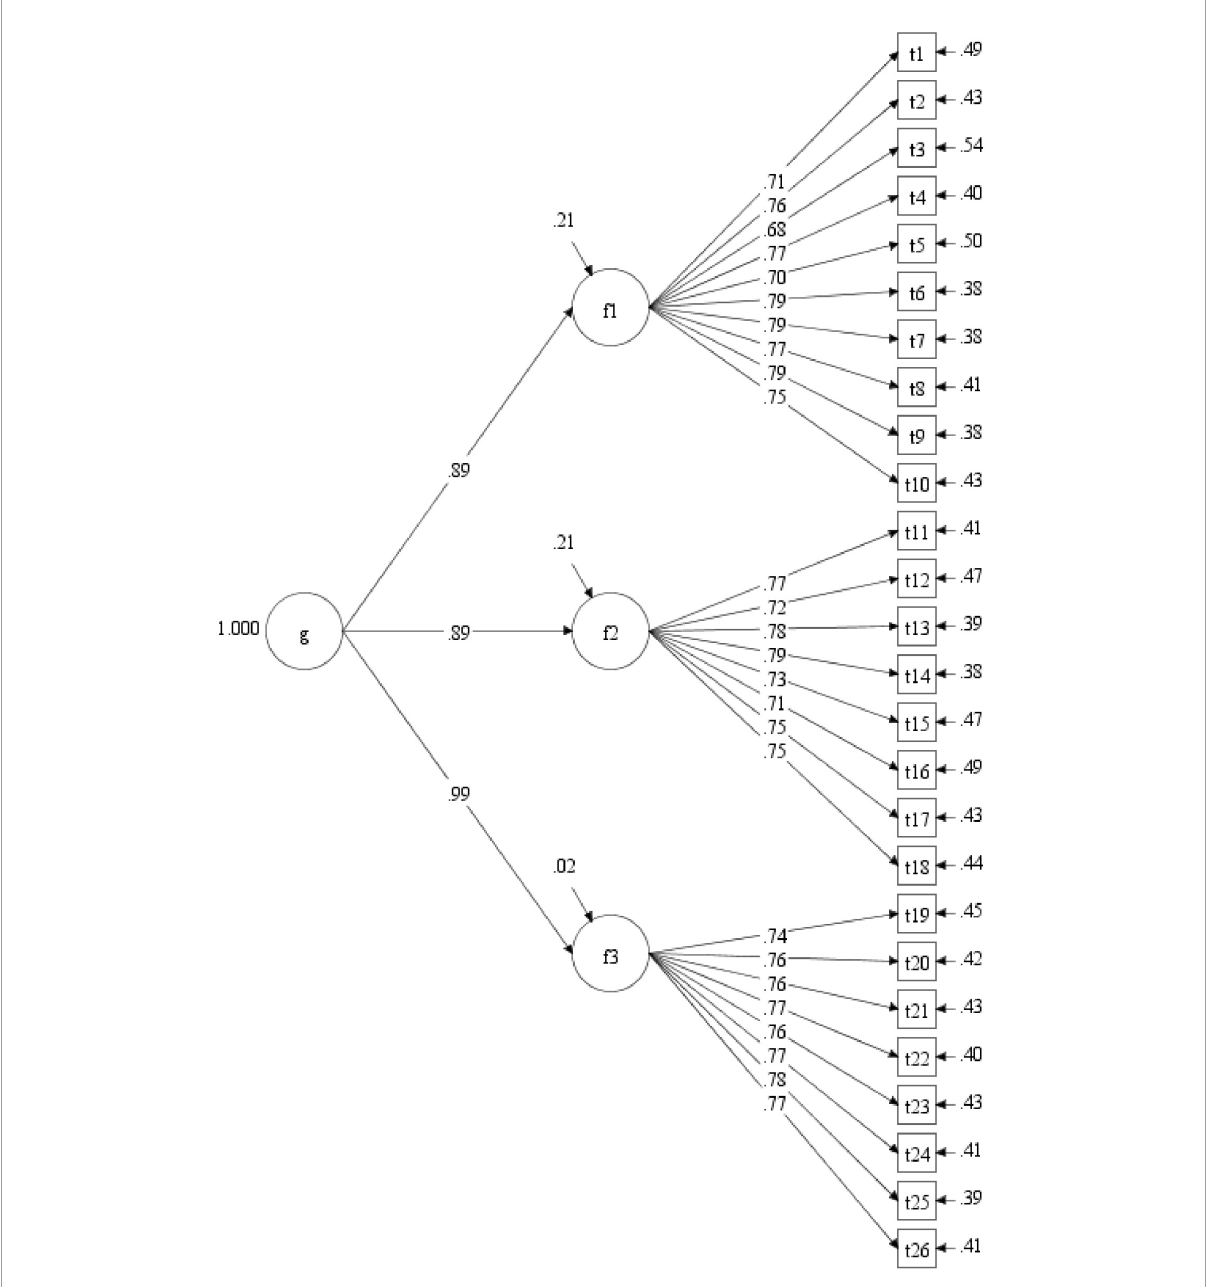
FIGURE3 Factor loadings for the higher-order